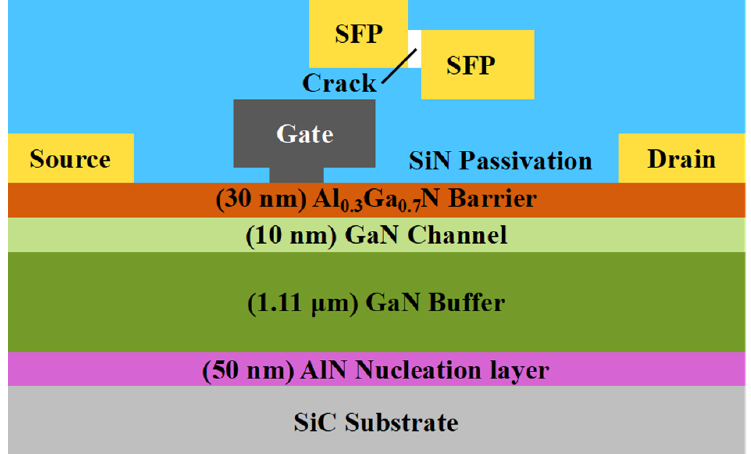
Figure 2. Cross-sectional illustration of the AlGaN/GaN HEMT with a cracked SFP.